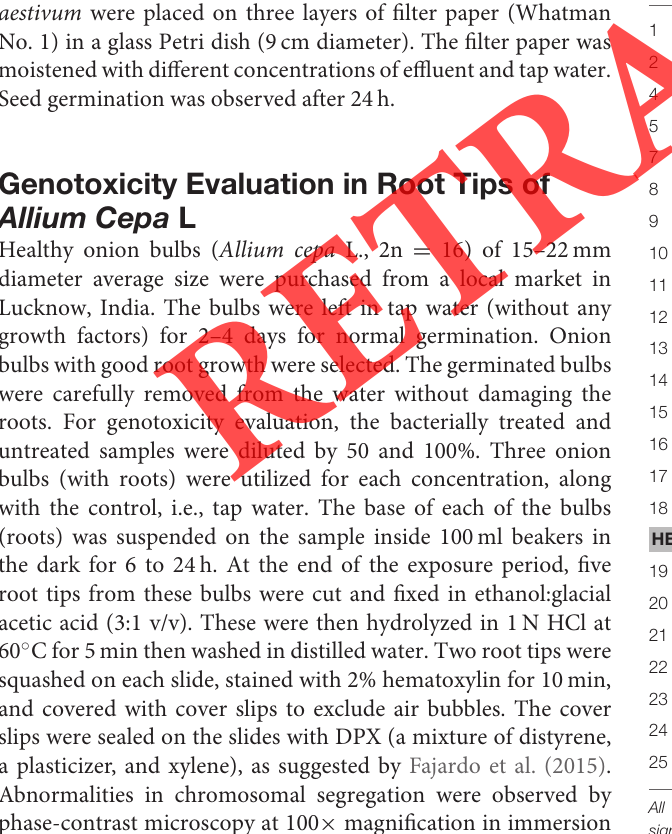
TABLE 1 | Physico-chemical characteristics of discharged pulp and paper mill effluent and their heavy metals content collected from M/S century pulp